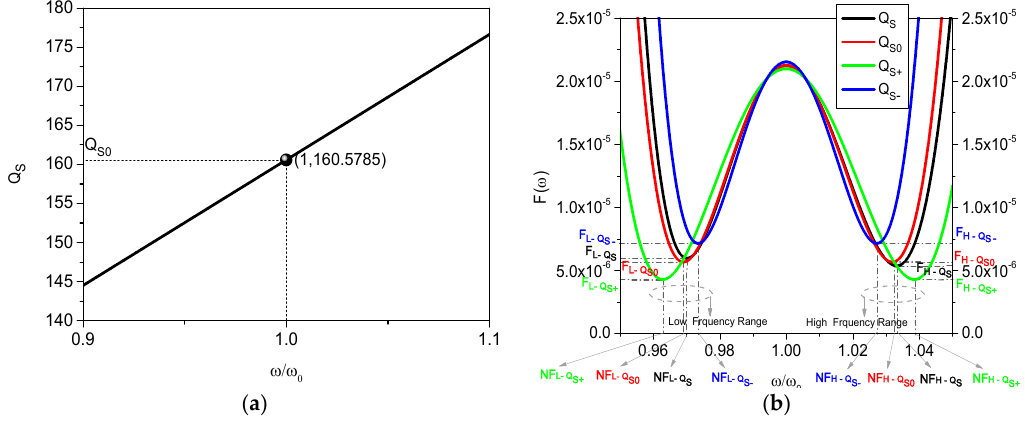
Figure 2. ( a ) Loaded Q ‐ factor of lossy TX vs. ω / ω 0 ; and ( b ) F ( ω , k TI , k IR ) for investigating PTE vs. ω / ω 0 with various loaded Q ‐ factor under k TI = 0.0053, k IR = 0.0666, = 0.5 and = 5. Table 1. Properties and graph of f( x ) = x 2 + b e0 x + c e0 for analyzing power transfer efficiency (PTE).